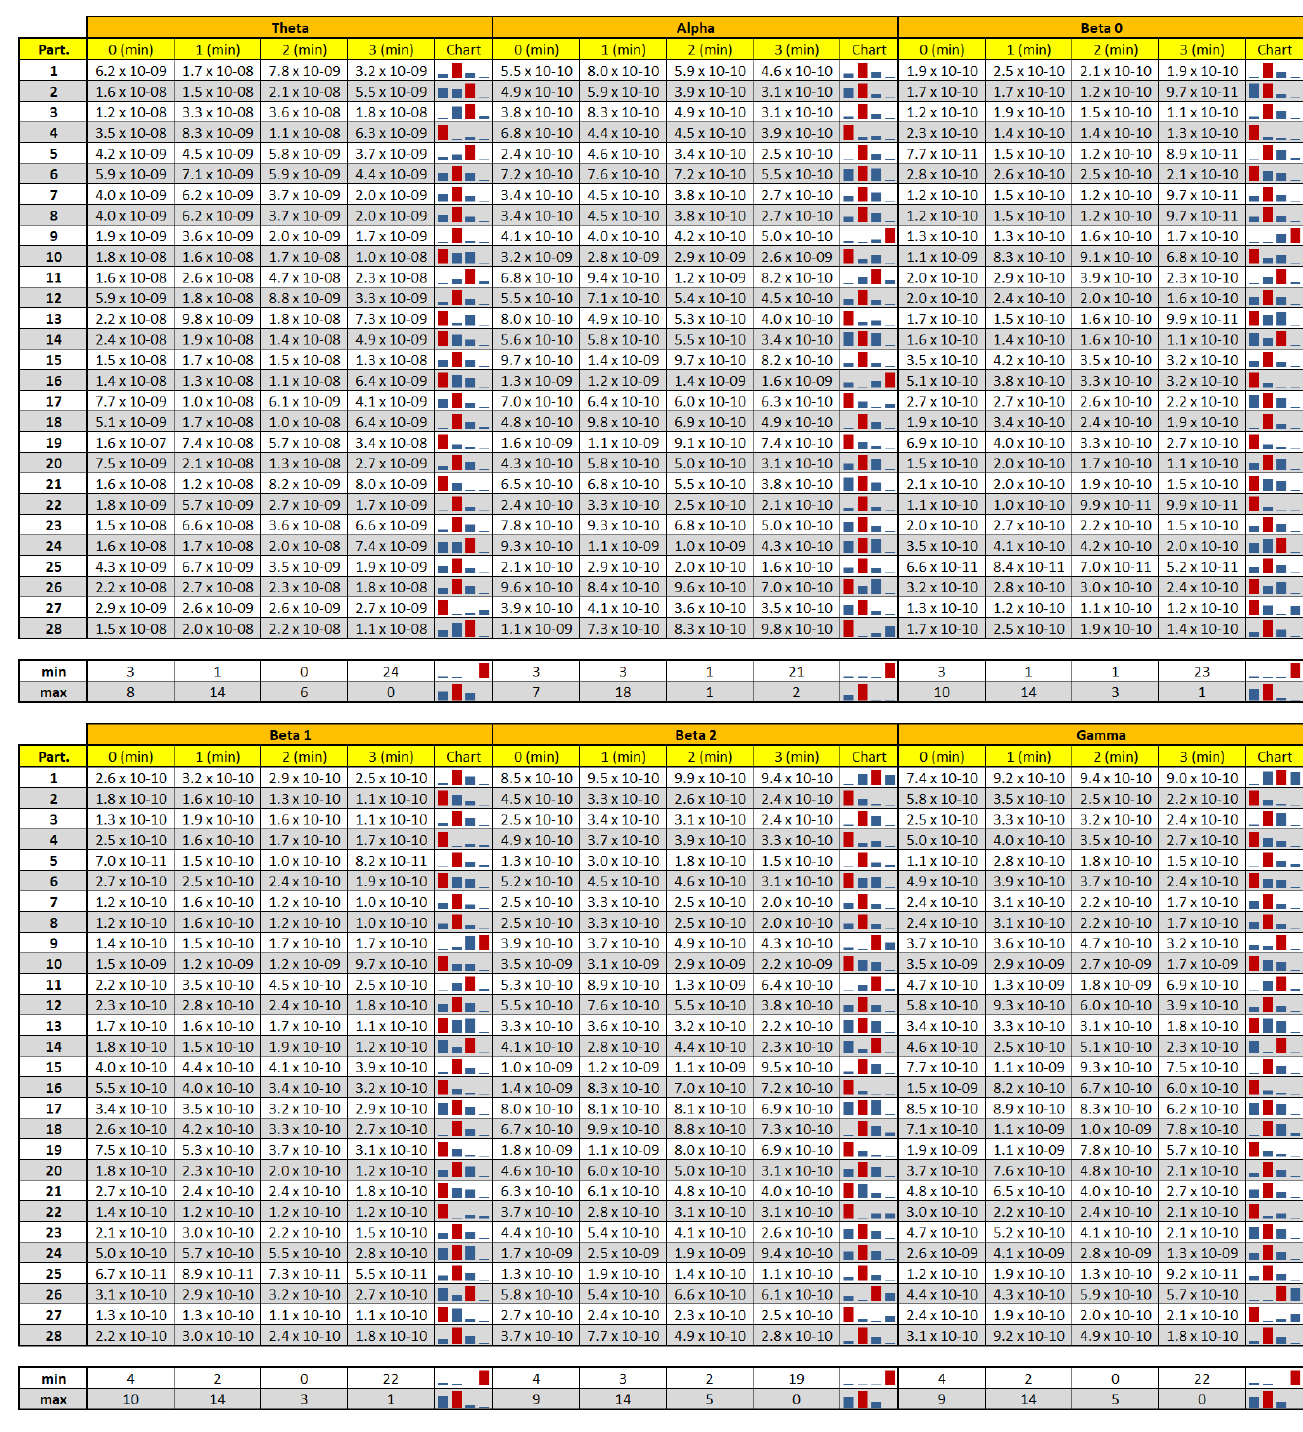
Figure A3. Average GFP values for individual brain waves and for individual participants calculated for stress. The means were counted for four minutes: 0 (min)—average for the minute before the event; 1, 2, 3 (min)—average for the consecutive minutes of the event. The number of minimum and maximum values for individual participants was summarized under the